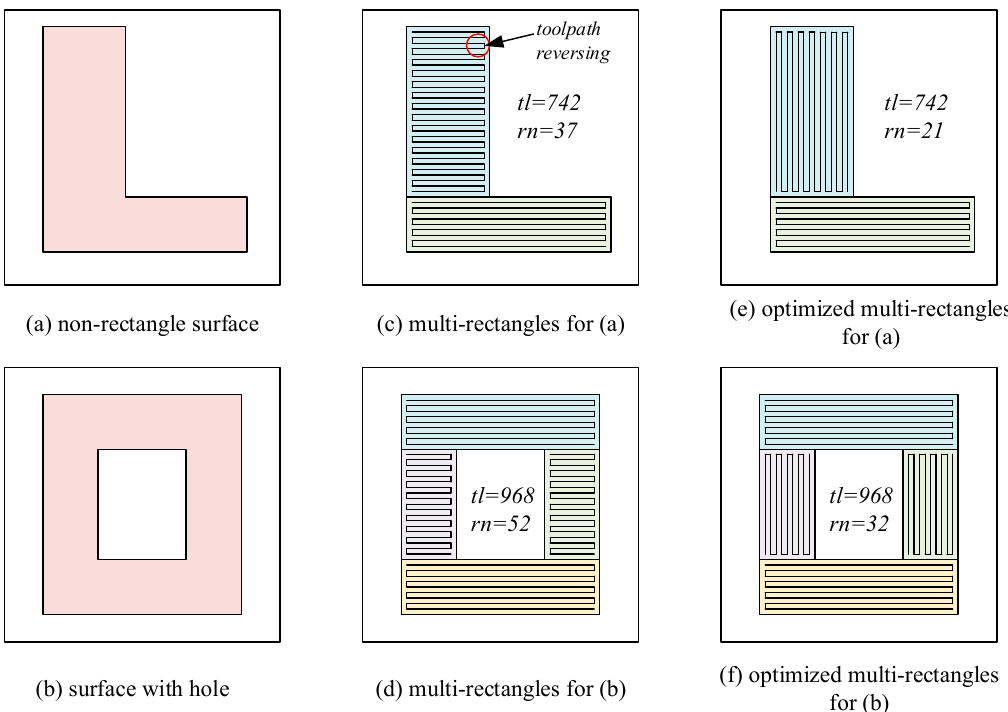
Figure 6. Optimized multi-rectangle algorithm, tl denotes the total length of toolpath, and rn denotes the revering number of toolpath.